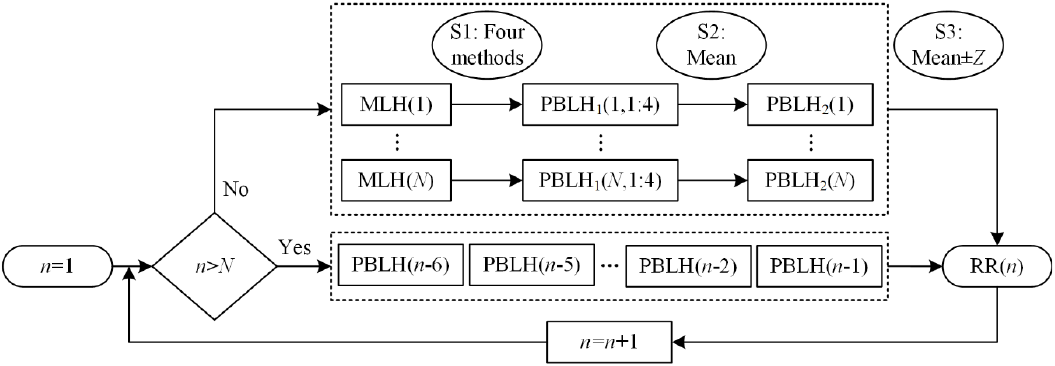
Figure 4. Schematic diagram of determining the range restriction (RR).